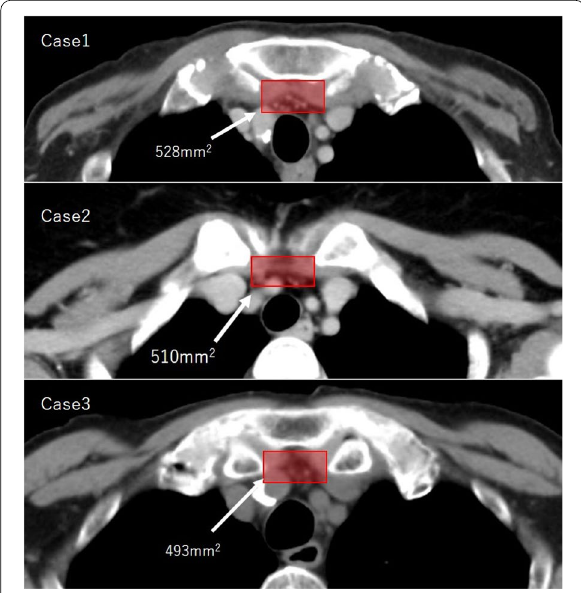
Fig. 3 Measurement of the thoracic inlet space (TIS) in each